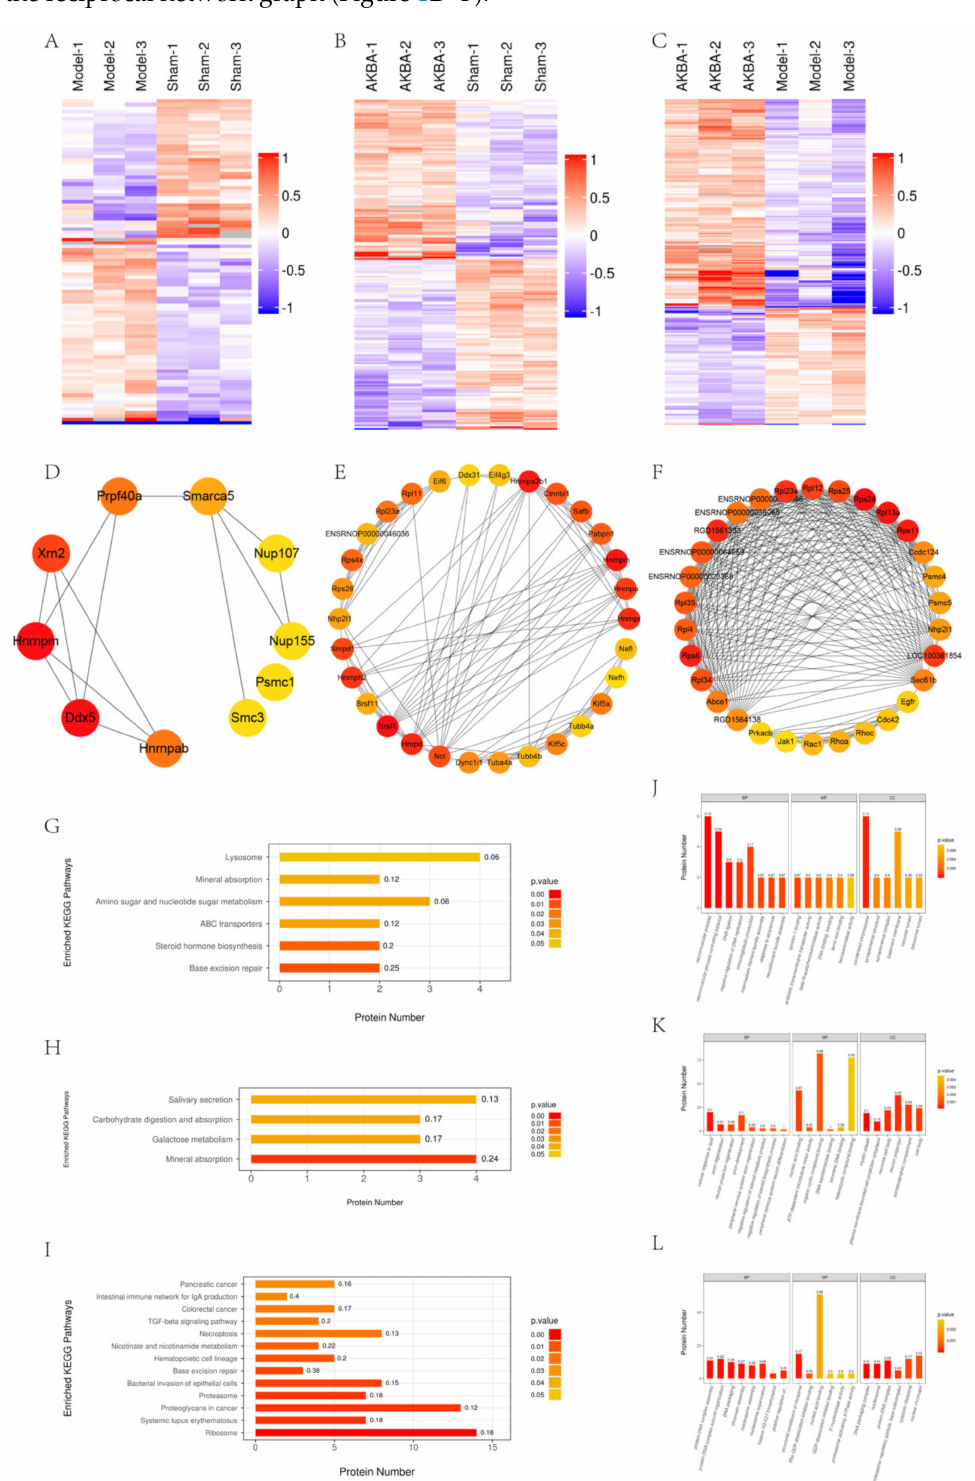
Figure 1. Bioinformatics analysis of proteomics. ( A – C ): Each row in the tree heatmap represents one protein (i.e., the vertical coordinate is the significantly differentially expressed protein, each column represents a group of samples, red represents significantly upregulated proteins, blue represents significantly downregulated proteins, and the gray part represents no quantitative information